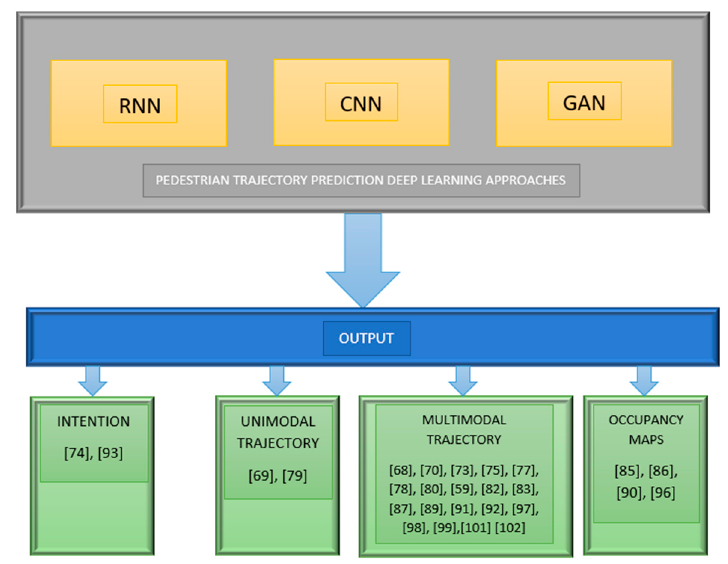
Figure 8. PTP DL-based techniques to references mapping.